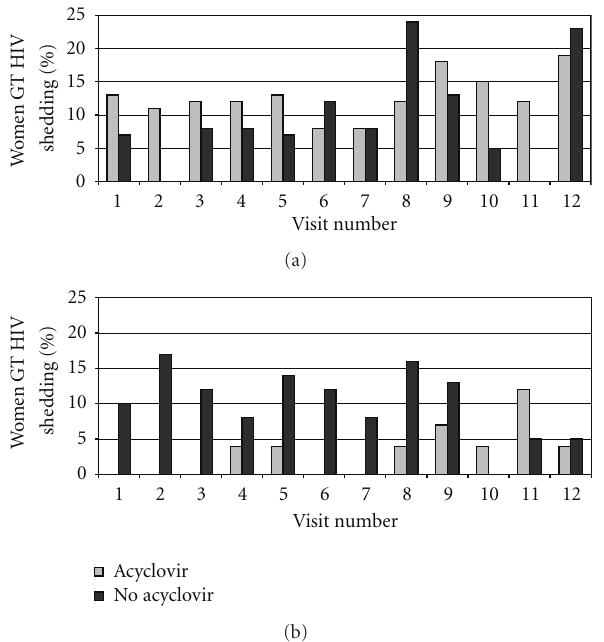
Figure 1: (a) Prevalence of GT HIV sheddingin women on HAART by arm. (b) Prevalence of GT HSV shedding in women on HAART by